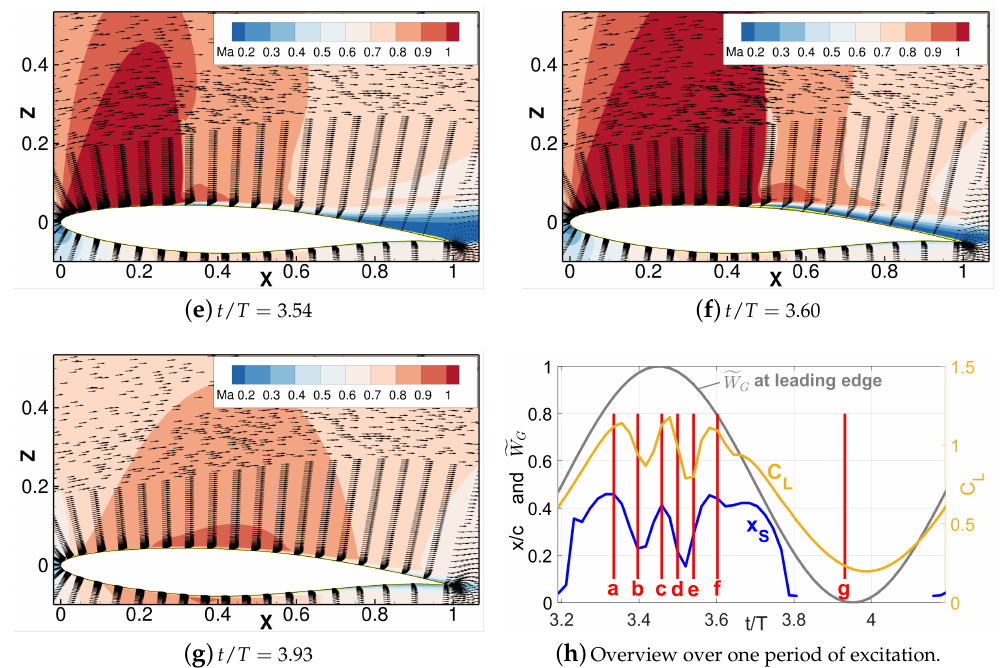
Figure 15. ( a – g ): Snapshots of Mach number contours including velocity vectors. Additionally, the yellow line in the field plots shows the contour for x-velocity = 0. ( h ): Lift, shock motion and (cid:16) (cid:17) W G / (cid:98) W G + 1 normalized gust velocity (cid:101) W G = 0.5 during one period of excitation.